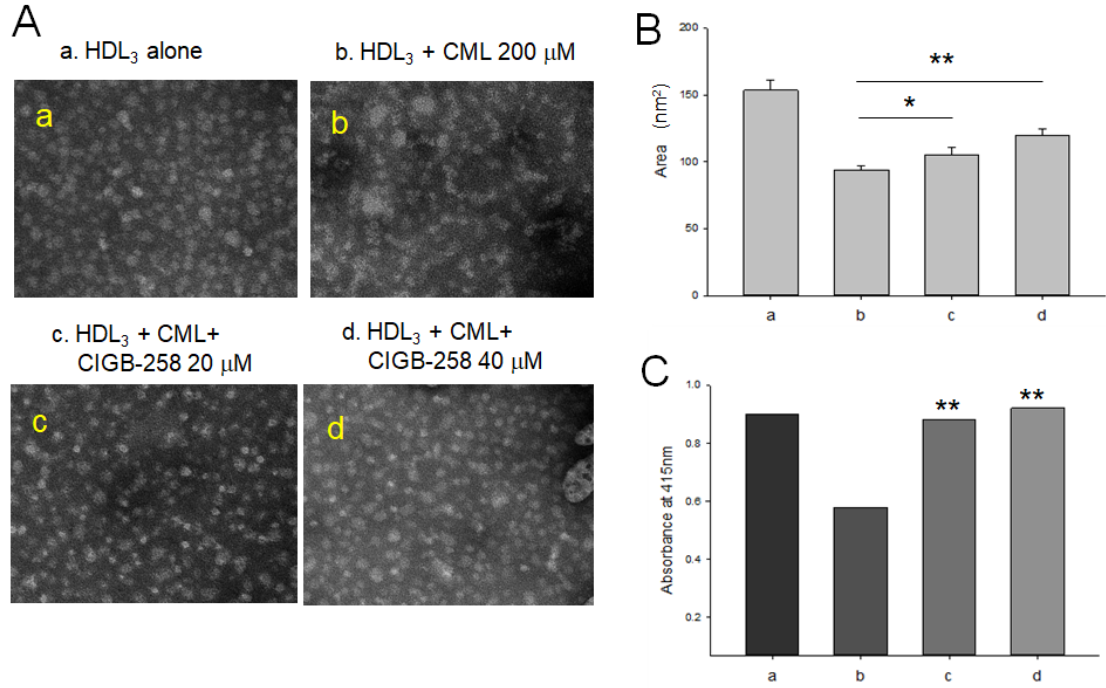
Figure 2. Measurement of high-density lipoproteins (HDL) particle morphology and antioxidant activity in the presence of N - ε -carboxymethyllysine (CML) and CIGB-258. a, HDL 3 (1 mg/mL) alone; b, HDL 3 + CML (final 0.2 mM); c, HDL 3 + CML (final 0.2 mM) + CIGB-258 (final 20 μ M); d, HDL 3 + CML (final 0.2 mM) + CIGB-258 (final 40 μ M). ( A ). Images of HDL 3 were visualized from transmission electron microscopy (TEM) after 48 h incubation in the presence and absence of CML and CIGB-258 (40,000×). ( B ). Comparison of HDL 3 particle size after 48 h incubation under presence and absence of CML and CIGB-258. *, p < 0.05 between b and c; **, p < 0.01 between b and d. ( C ). Comparison of paraoxonase activity from each HDL 3 after 48 h incubation in presence and absence of CML and CIGB-258. **, p < 0.01 versus CML alone (b).